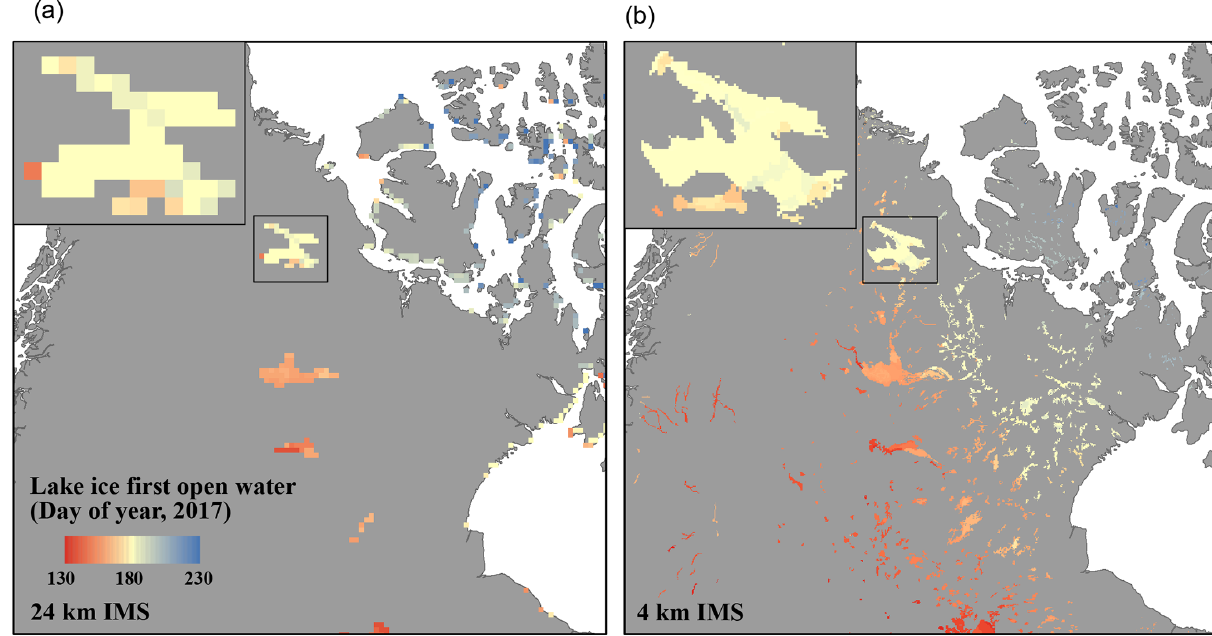
Figure 2. Comparison of 24km (a) and 4km (b) lake ice first open water in 2017.